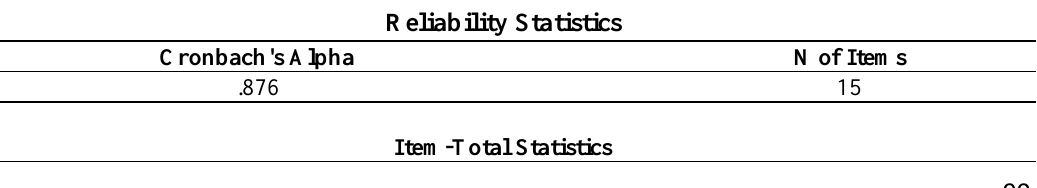
Table.1. Reliability [Cronbach’s alpha] and Item Total